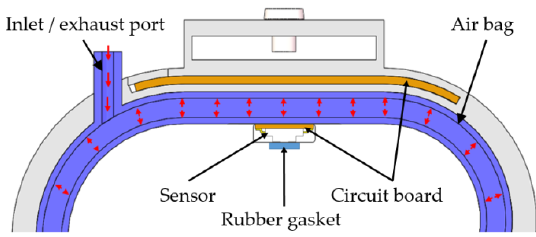
Figure 5. Schematic diagram of pressurization process.